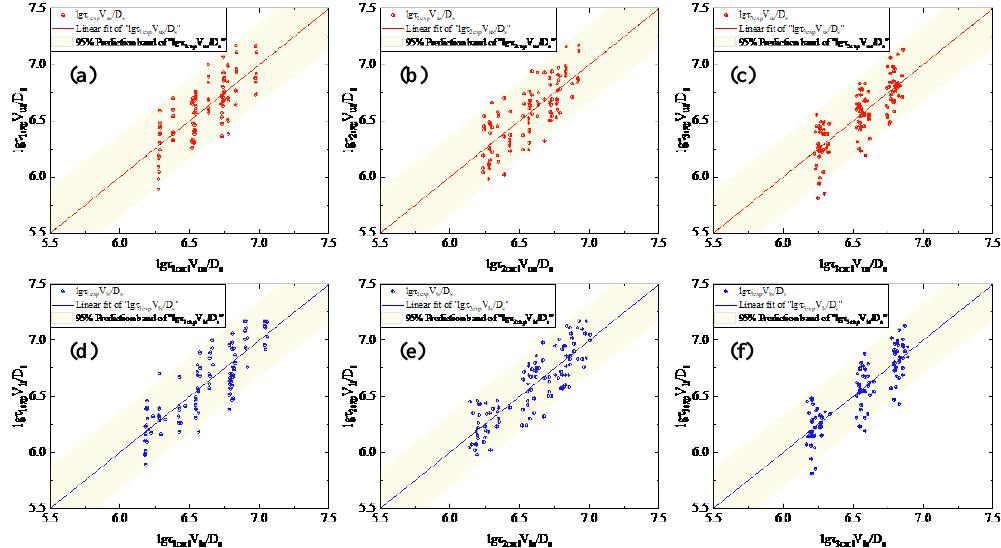
Figure 12. Comparison of experimental lg τ V s / D s with calculated ones for upper side nozzle ( a – c ) and lower side nozzle ( d – f ), respectively, using τ 1 , τ 2 , τ 3 .